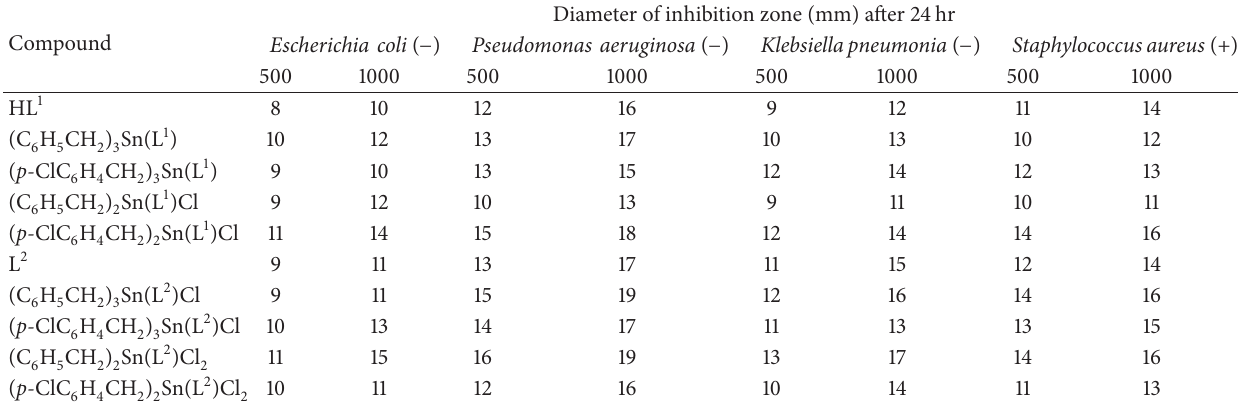
Table 6: Antibacterial activity of theophylline and theobromine complexes.